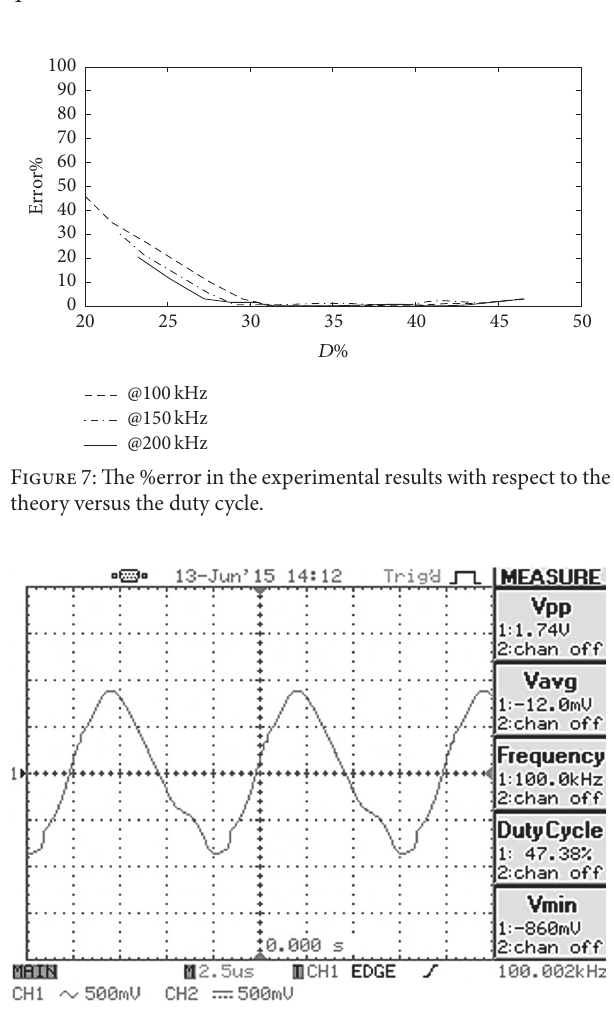
Figure 8: Plot of ripple voltage versus time at 100kHz and 𝐷 = 18%.